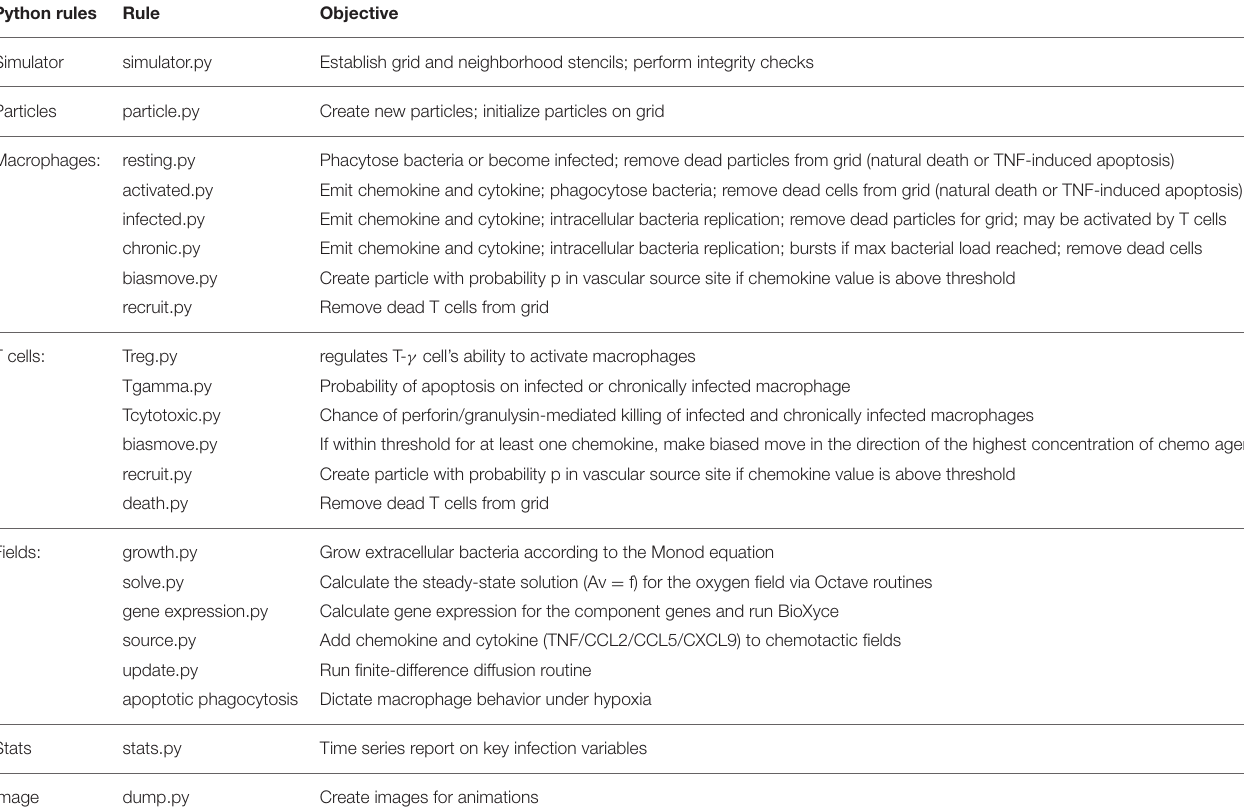
TABLE 3 | Summary of the Python modules developed for the multiscale simulator. Python